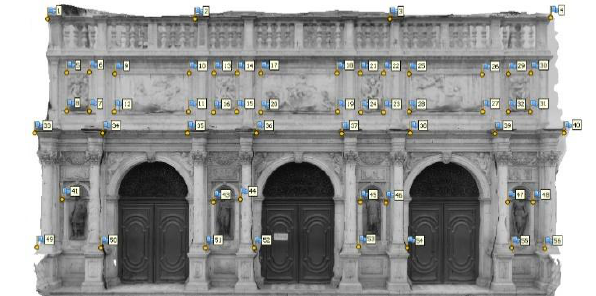
Figure 12. Mesh of the ’96 photogrammetric model.